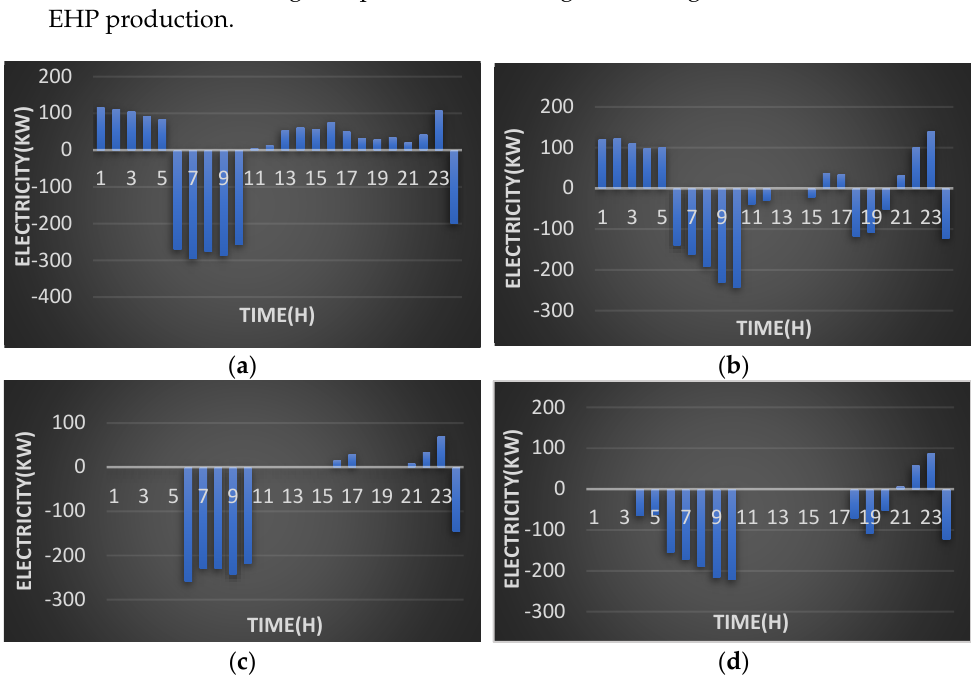
Figure 10. Optimal exchange power with grid, negative (purchasing) and positive (selling). ( a ) scenario 1 ( b ) scenario 2 ( c ) scenario 3 ( d ) scenario 4.